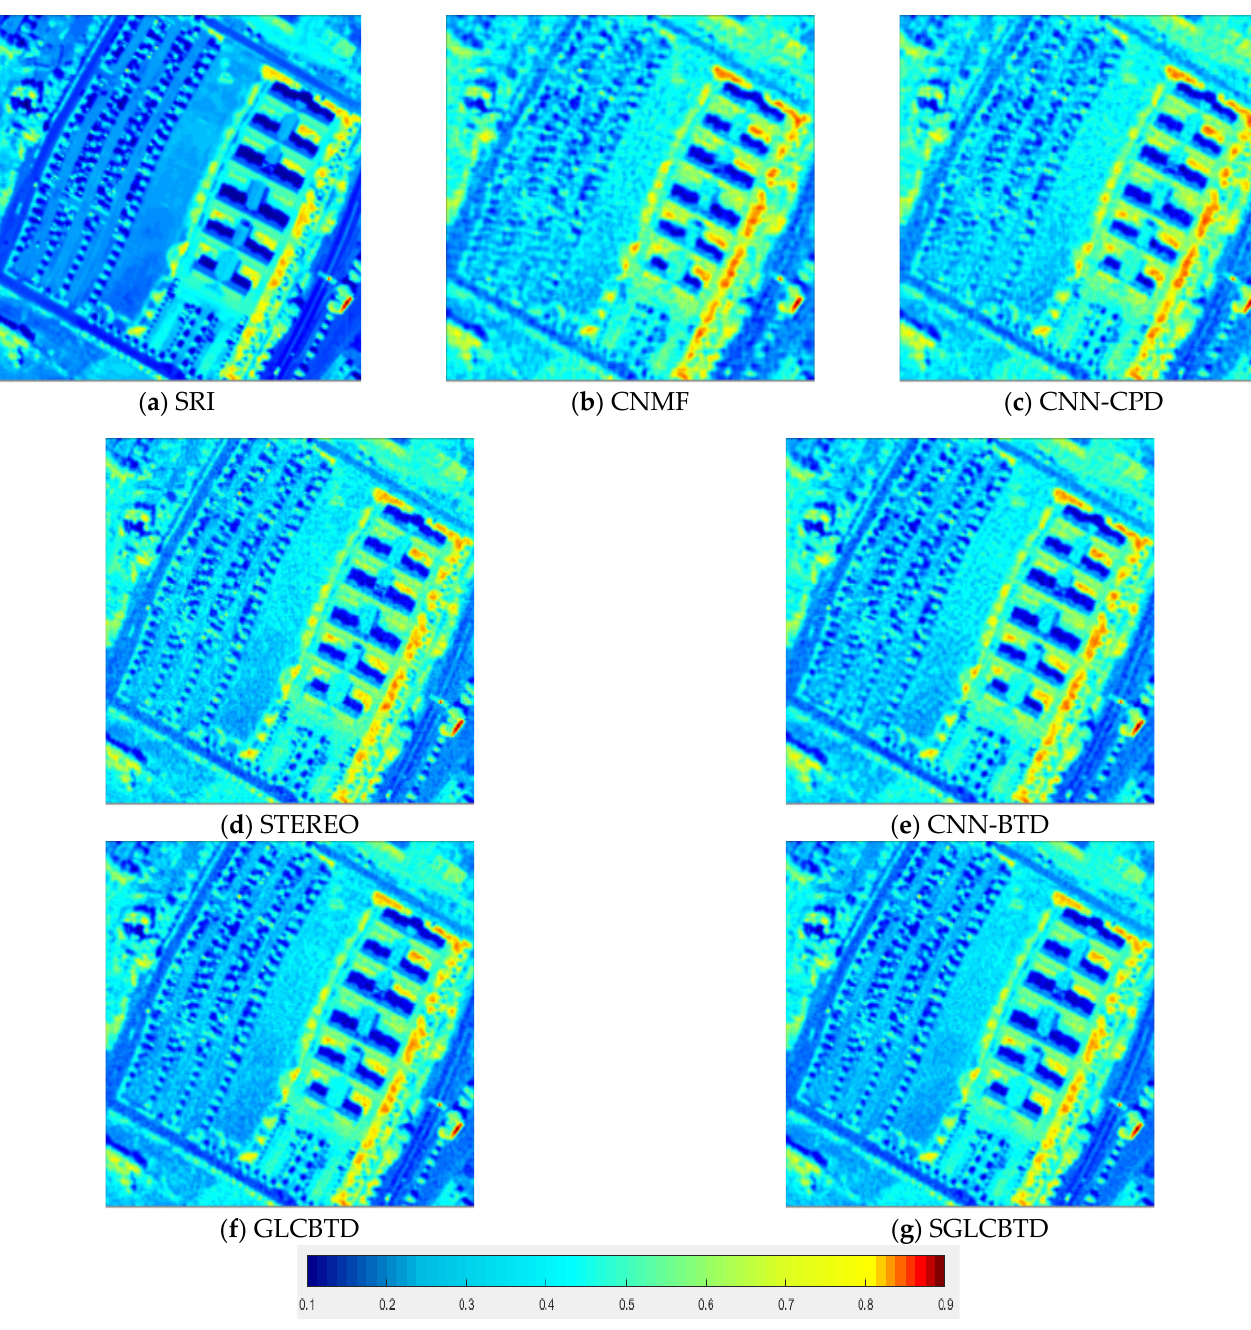
Figure 8. Comparisons of the fusion results of the 80-th band on the Pavia University dataset.